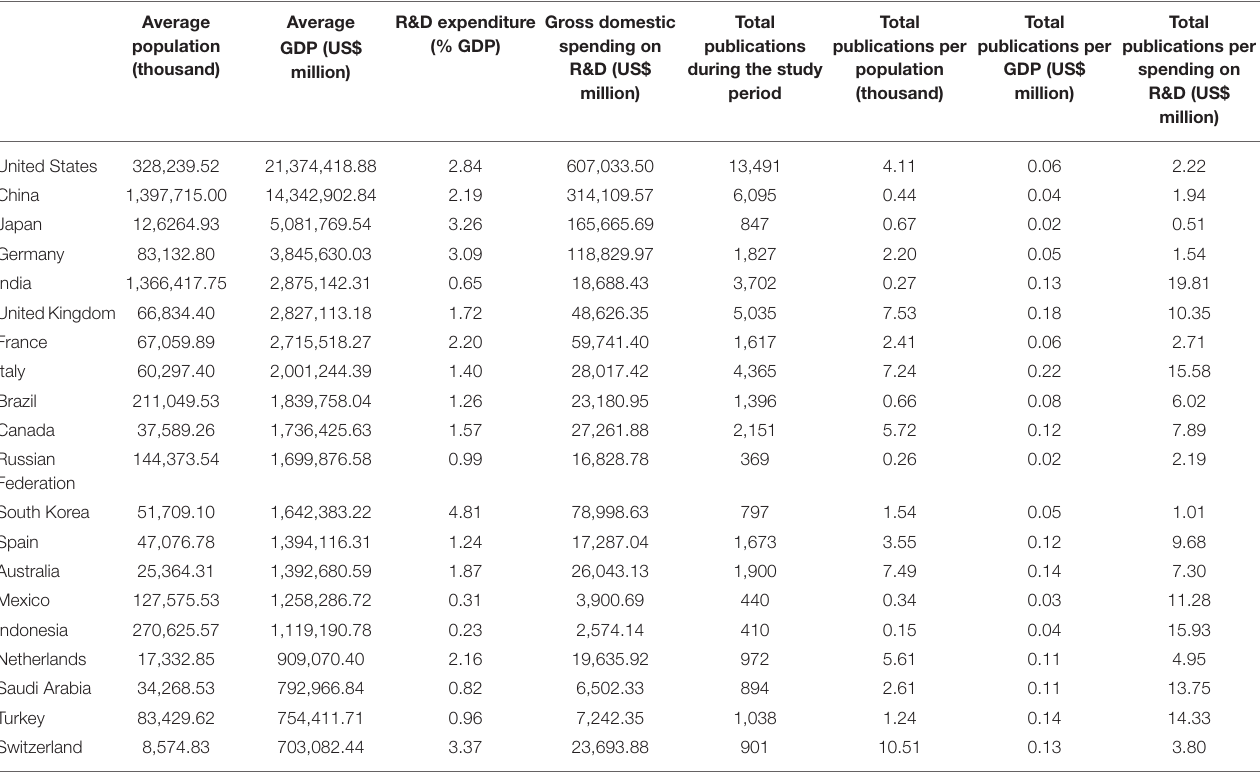
TABLE 2 | Adjusted early research productivity on COVID-19 from the 20 highest-ranked countries according to GDP. Average